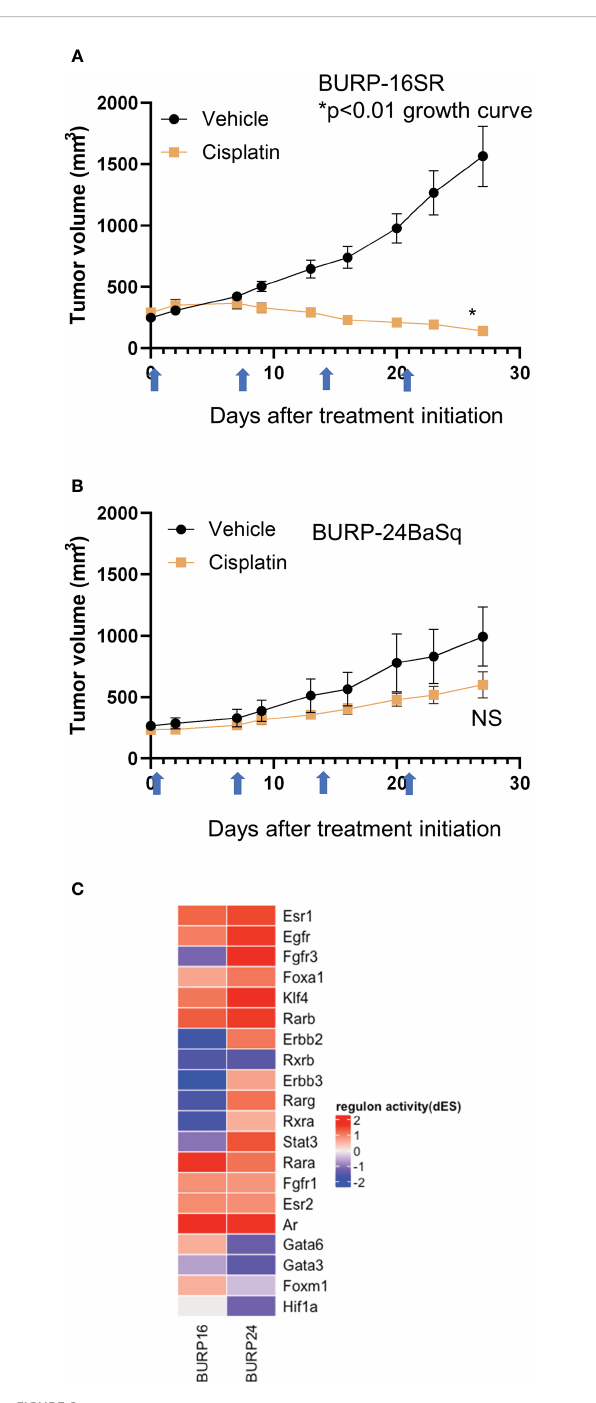
FIGURE 8 Response of BURP-16SR and BURP-24BaSq tumor lines to cisplatin treatment and regulon activity. (A, B) Cisplatin treatment (10mg/kg, IV) was initiated when tumors reached 200 mm 3 . Mice were treated on days 0, 7, 14, and 21 (indicated by blue arrows) and tumor growth is determined by caliper measurements twice a week. BURP-16SR n=10 each cohort, * growth curve p<0.01 unpaired t-test. (B) BURP-24BaSq n=9 cisplatin and n=8 vehicle cohorts, NS= not signi fi cant difference in growth curve p=0.10 unpaired t-test. (C) Unsupervised clustering of regulon activity of BURP-16SR and BURP-24BaSq models. The regulons evaluated are identi fi ed to be relevant to bladder cancer as represented in Kamoun et al. The color represents differential regulon activity, with red representing active status and blue representing inactive